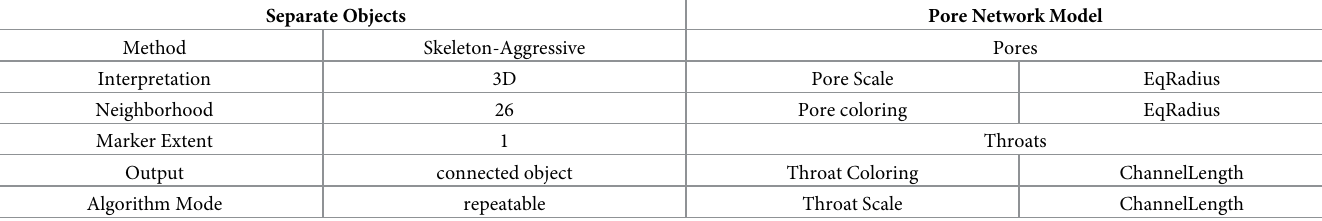
Table 2. Parameters utilized in separate objects and generate pore network model